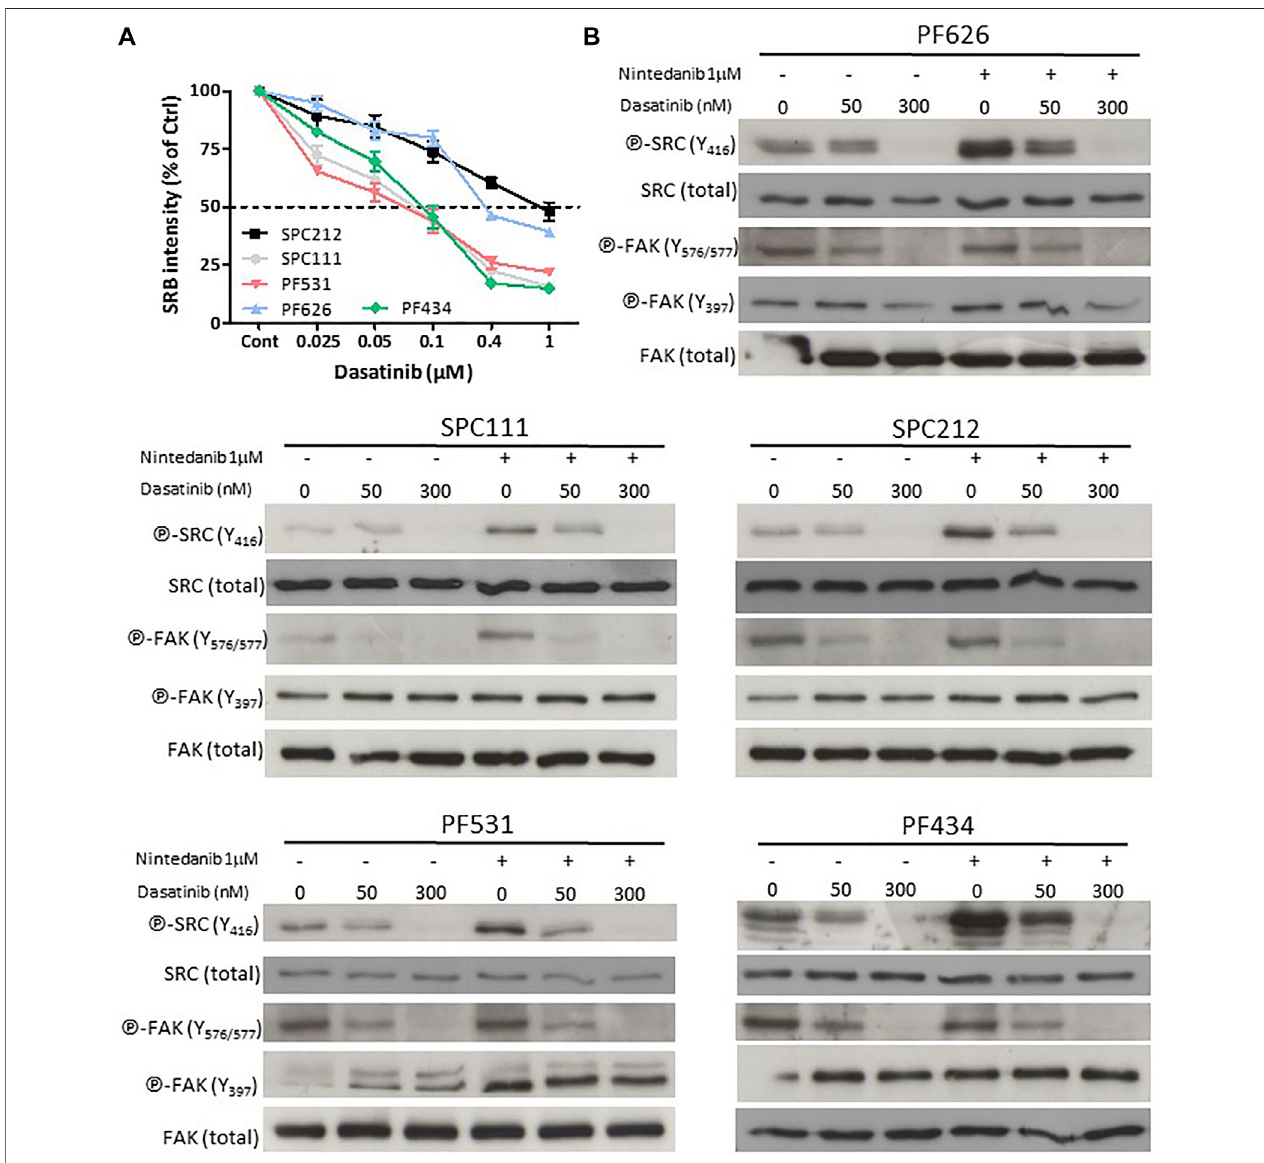
FIGURE 2 | Dasatinib reversed the nintedanib-induced SRC activation (A) Cells were treated with dasatinib for 72 h and cell viability was analyzed with SRB assay (B) Cells were treated with 50 nM or 300 nM dasatinib, alone or in combination with 1 μ M nintedanib for 24 h, and protein samples were analyzed by western blot. All experiments were performed in triplicates. Bars represent means ± SEM from three independent experiments.